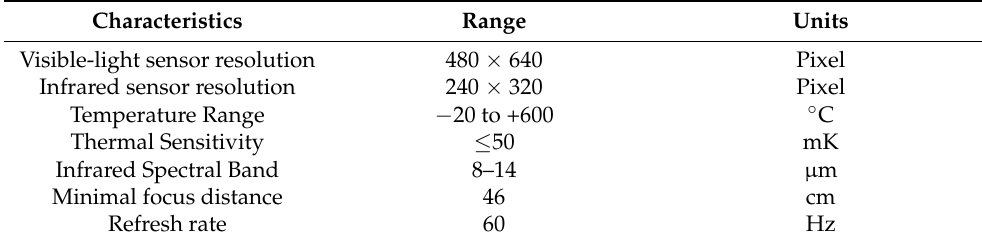
Table 4. Fluke Ti32 Commercial Thermal Imager